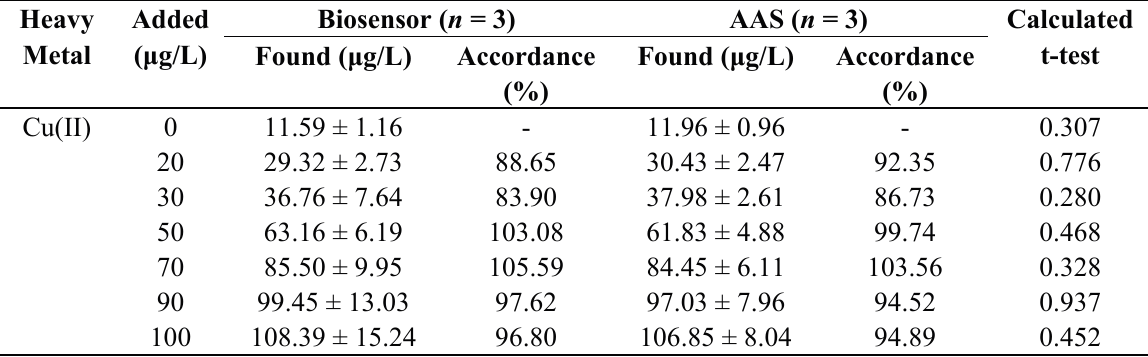
Table 7. Accordance of Cu(II), Cd(II), Pb(II) and Zn(II) ions spiked in Jeram landfill leachate by both developed A. fischeri -based biosensor and AAS